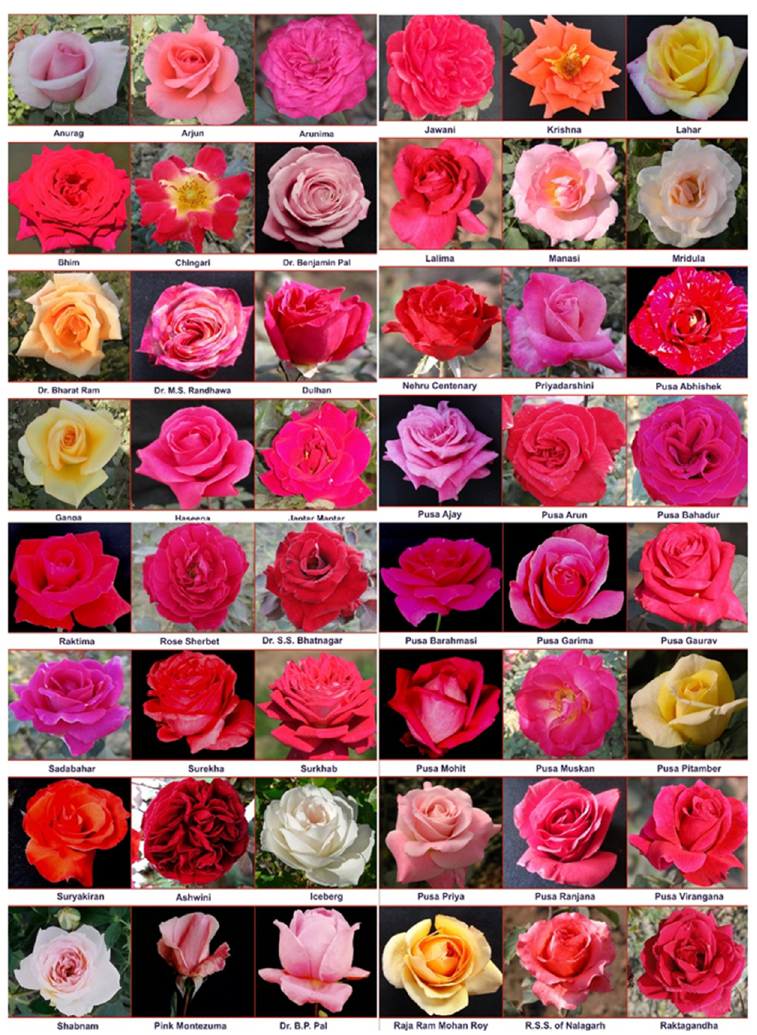
Figure 1. Variability in the flower color of rose varieties used in the present study. Table 1. List of rose varieties along with their parentage, group, and color. Sr. No.